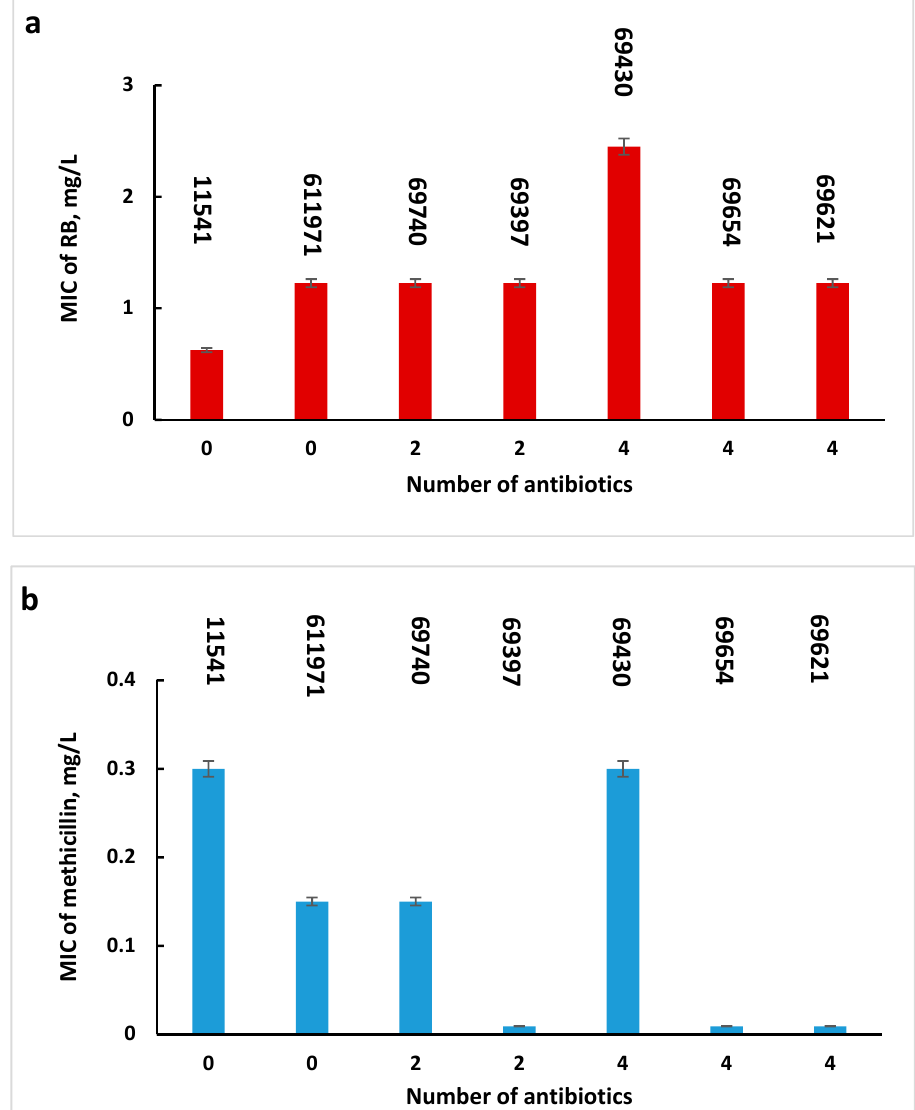
Figure 2. MIC values of Rose Bengal ( a ) and of methicillin in the presence of sub-MIC concentrations of Rose Bengal ( b ) for MSSA and MRSA strains resistant up to 4 antibiotics. Error bars represent standard errors.